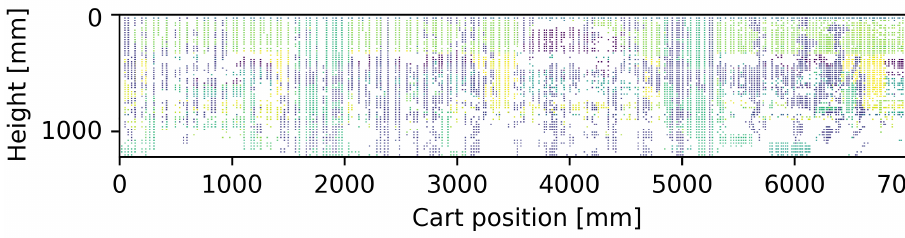
Figure 6. Collected data with LIDAR.